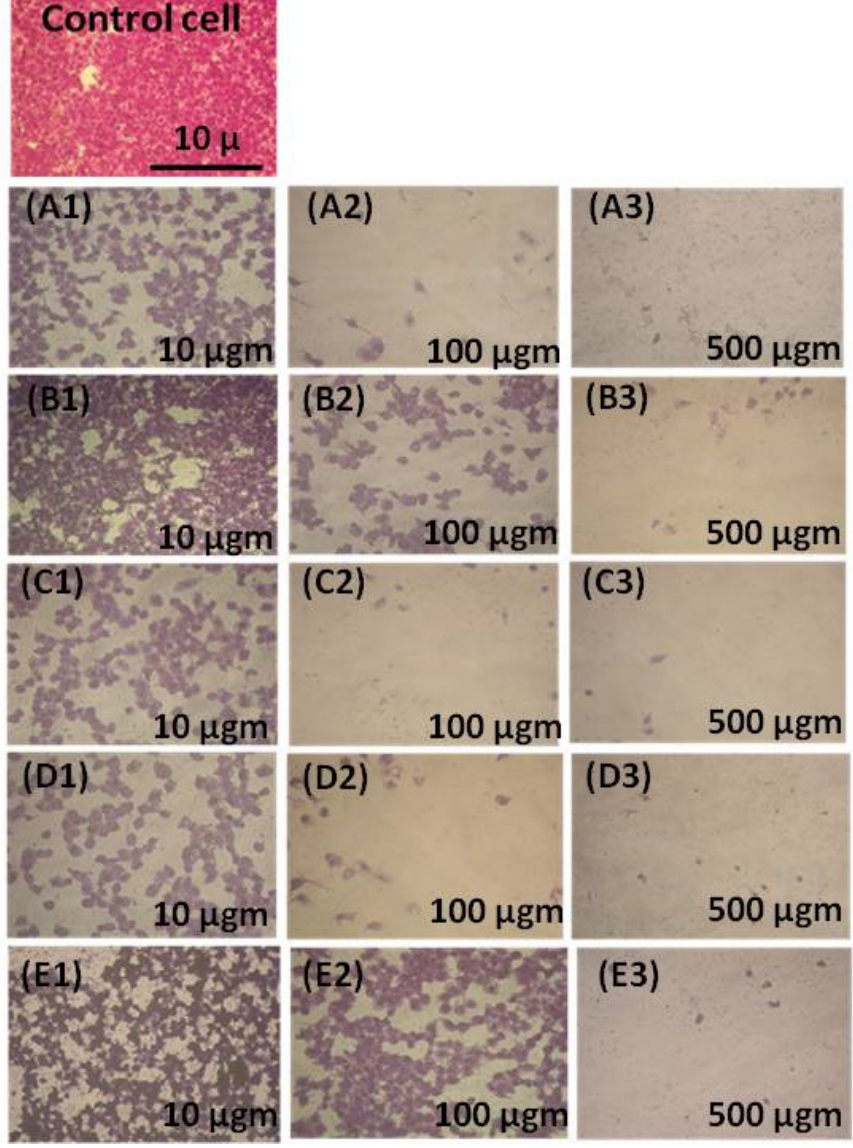
Figure 3. SEM images for CACO-2 control untreated sample (X) and samples treated with 10